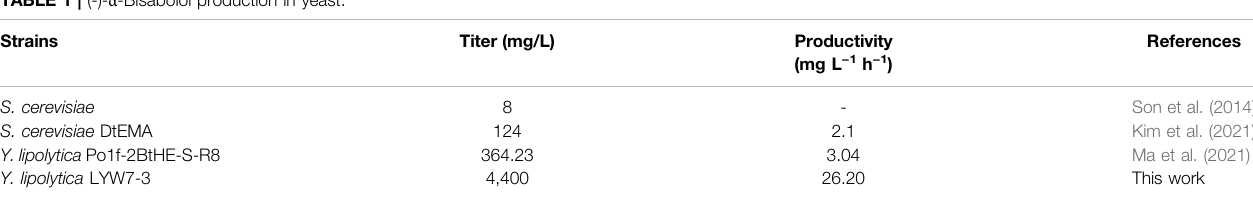
TABLE 1 | (-)- α -Bisabolol production in yeast.